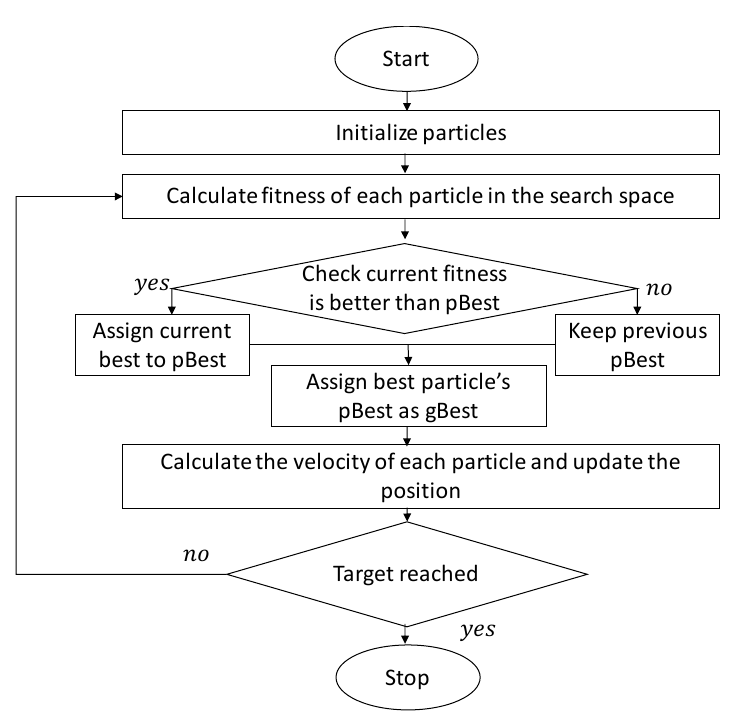
Figure 5. Flowchart of the PSO algorithm.